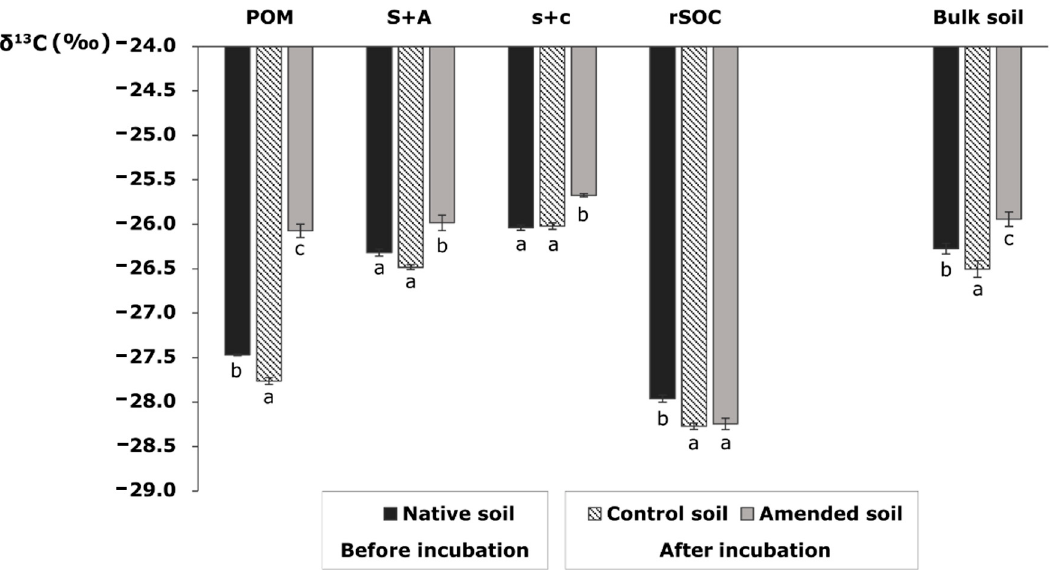
Figure 2. δ 13 C values of the bulk forest soil and of the soil fractions (POM = particulate organic matter; S + A = sand and stable aggregate fraction; s + c = silt plus clay-sized fraction; rSOC = chemically resistant SOC fraction) separated from the native soil before incubation and from the control and maize-amended samples after the 163-day incubation. Line bars indicate standard error. Different letters indicate significant differences (ANOVA, p < 0.05) among the treatment categories within an SOM fraction.